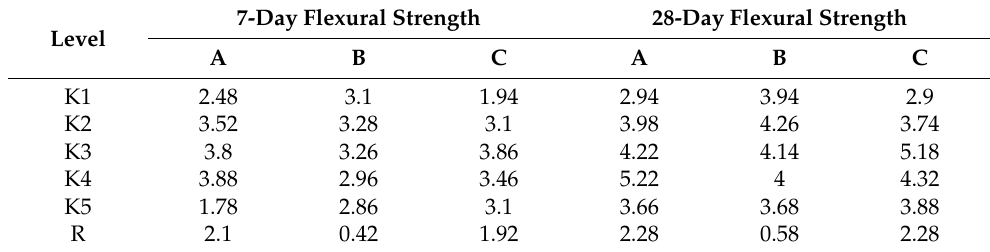
Table 7. Range analysis of flexural strength